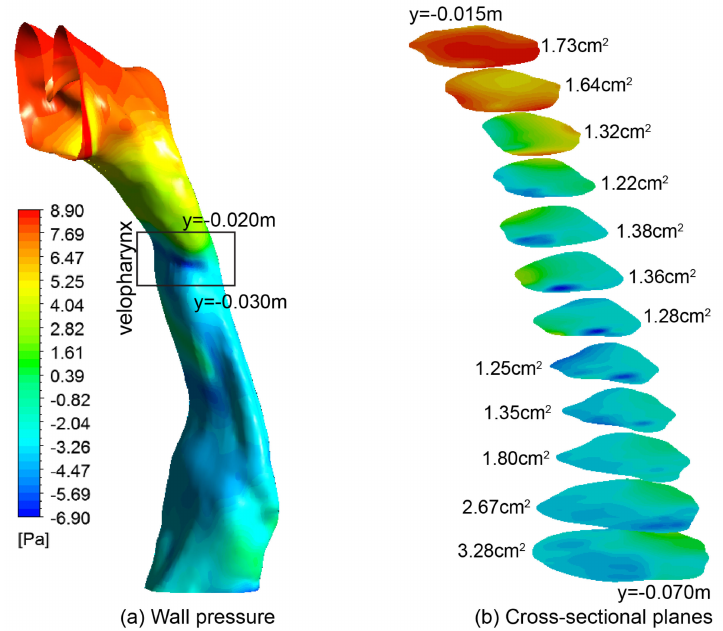
Figure 9. ( a ) Pressure contours at the wall; ( b ) Pressure contours at 12 cross-sectional slices. The cross-sectional area is given in cm 2 for each